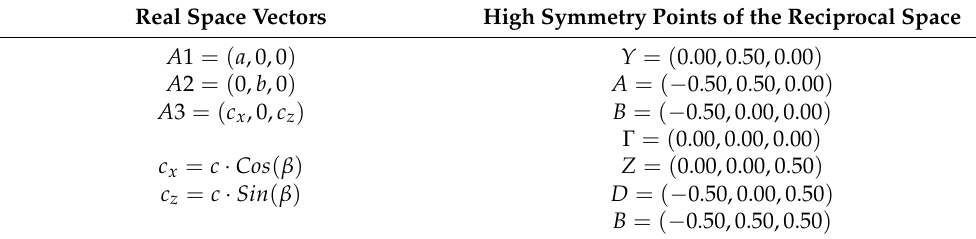
Table A1. Conventional lattice vectors and high symmetry points of the reciprocal of the C 10 H 13 BO 3 S compound.